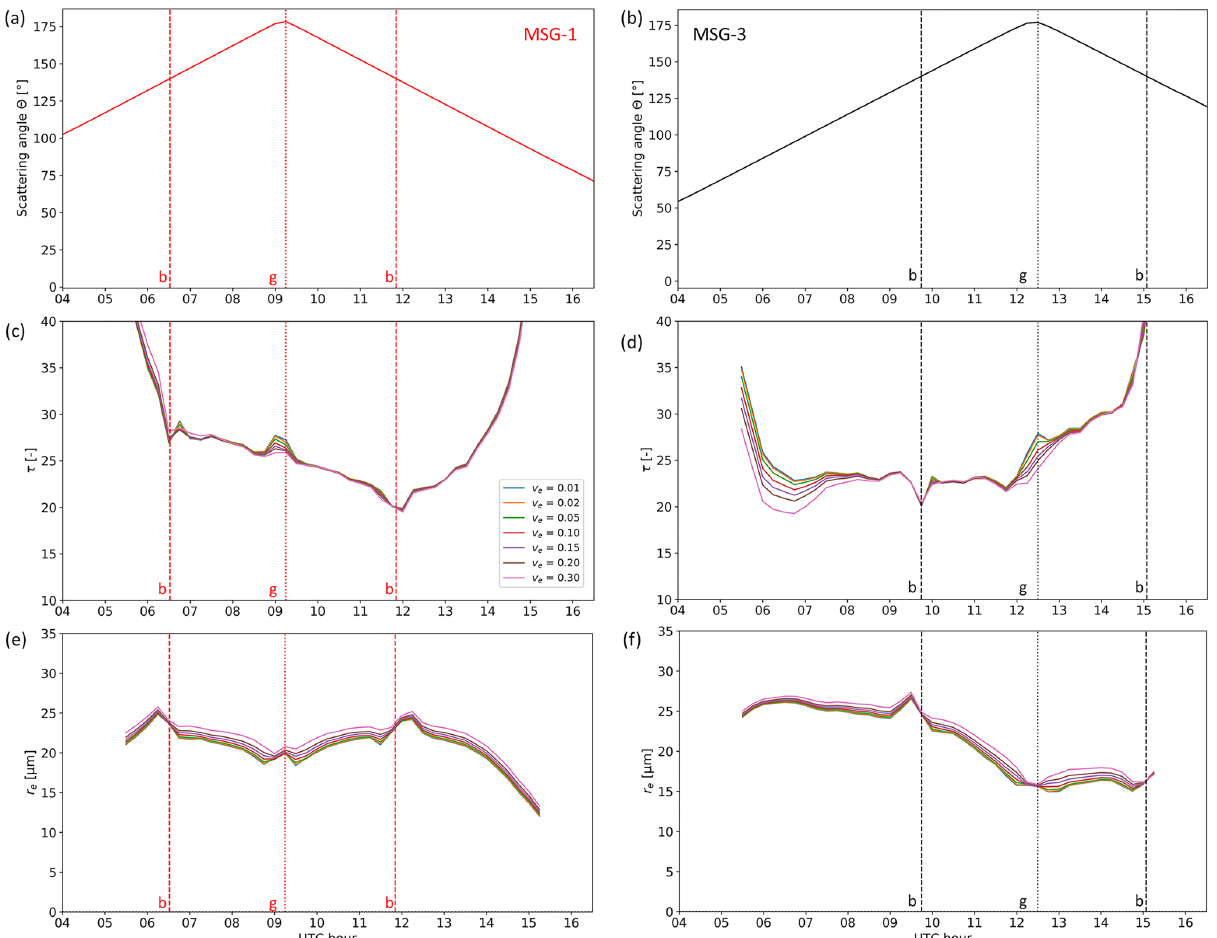
Figure 12. Scattering angles (a, b) and CPP retrievals of τ (c, d) and r e (e, f) based on the 0.6–1.6µm channel, shown separately for MSG- 1 (a, c, e) and MSG-3 (b, d, f) , for the seven values of ν e examined on 20 March 2017 over the continental region shown in Fig. 1. The vertical lines represent cloud glory (dotted, denoted with “g”) and cloud bow (dashed, denoted with “b”) geometries for MSG-1 (red) and MSG-3